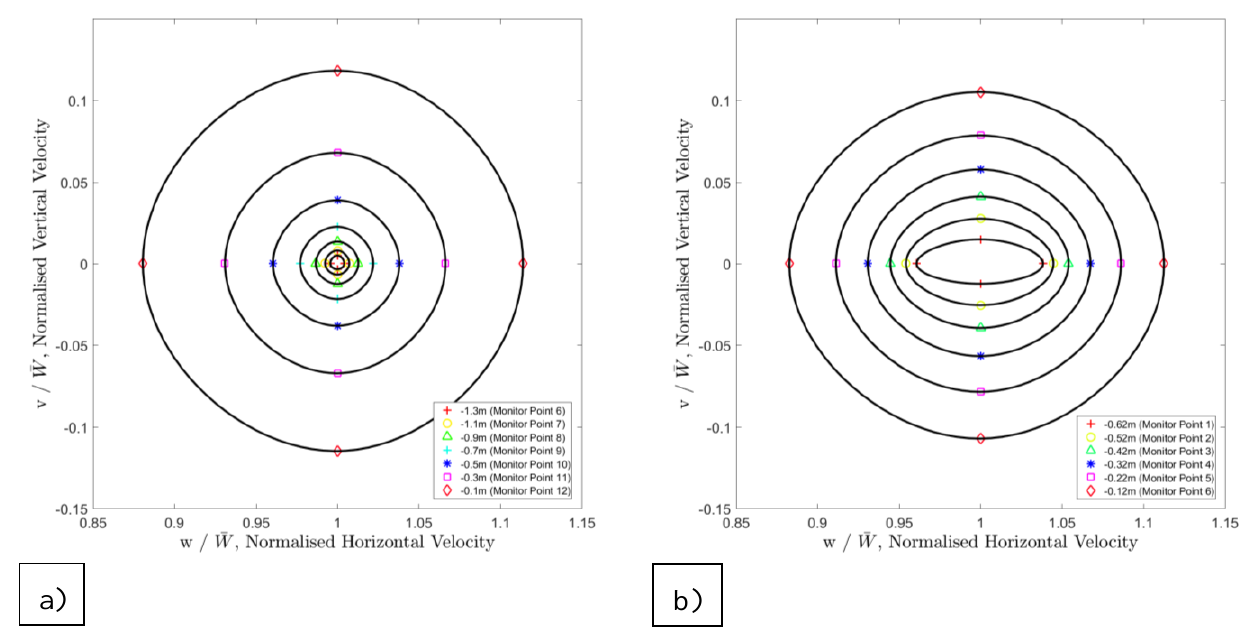
Figure 16. Normalised maximum and minimum, horizontal and vertical velocities to give an idea of the shape and magnitude of the velocity orbitals for a) deep and; b) intermediate water wave conditions for Wave